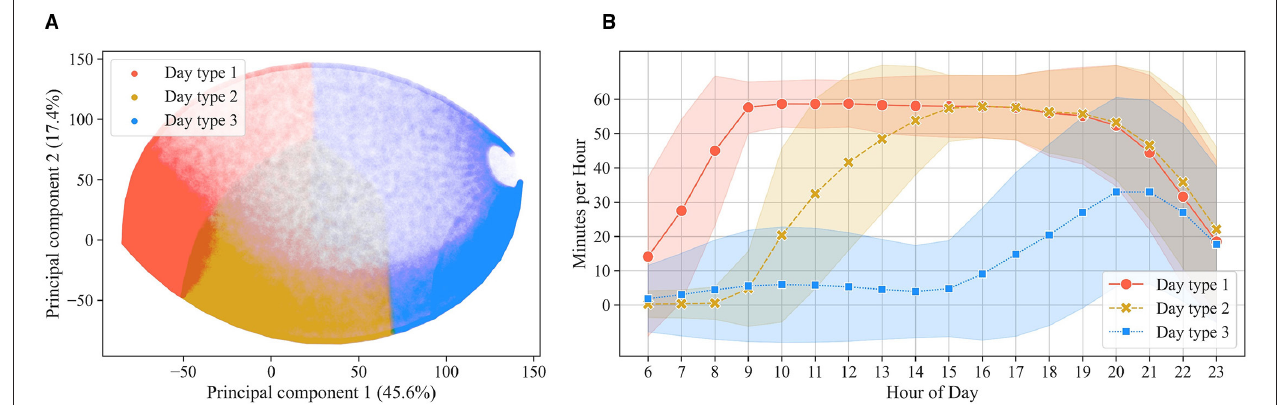
TABLE 1 | Comparison of four different clustering techniques [K-means, HAC (Euclidean distance), HAC (Pearson correlation), and HDBSCAN] based on three internal validation metrics (Silhouette, Davies-Bouldin, and Caliñski-Harabasz). HDBSCAN HAC K-means HAC (Pearson correlation) (Pearson correlation and (Euclidean distance and average linkage) Ward’s method) Silhouette (Higher is better) 0.4539 0.4264 0.6400 0.7604 Davies-Bouldin (Lower is better) 0.8267 0.7169 0.6001 0.4176 Caliñski-Harabasz (Higher is better) 18,473 13,732 35,802